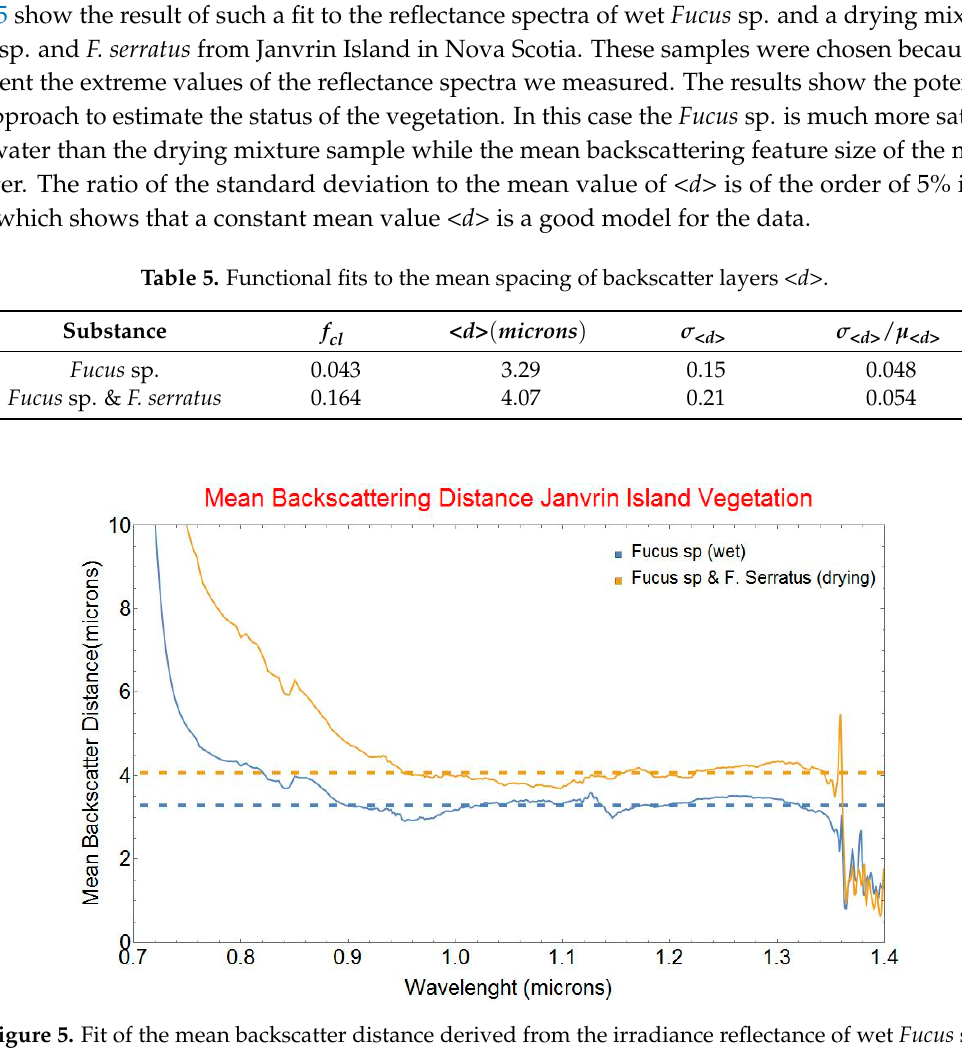
Figure 5. Fit of the mean backscatter distance derived from the irradiance reflectance of wet Fucus sp. and a drying mixture of Fucus sp. and F. serratus from Janvrin Island in Nova Scotia. In the zone below 0.90 microns the absorption of the chlorophyll-a and various pigments starts to dominate while in the zone above 1.35 microns the absorption of water becomes large enough that the resulting irradiance reflectance signal is dominated by noise. The full parameters of the fit are given in Table 5.